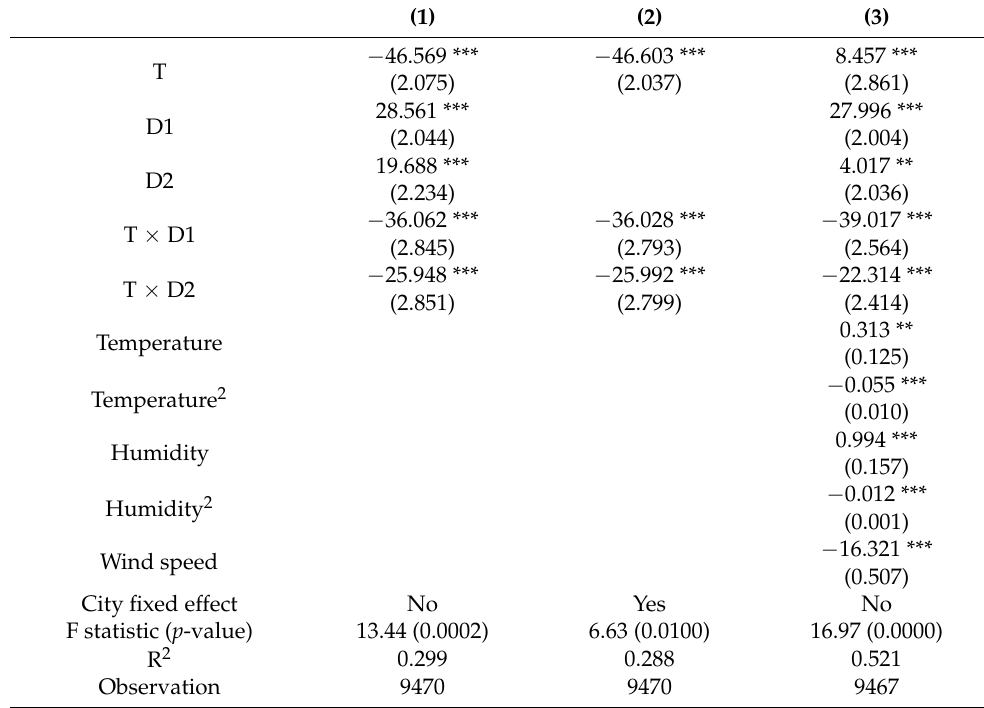
Table 3. Regression results: Heating season